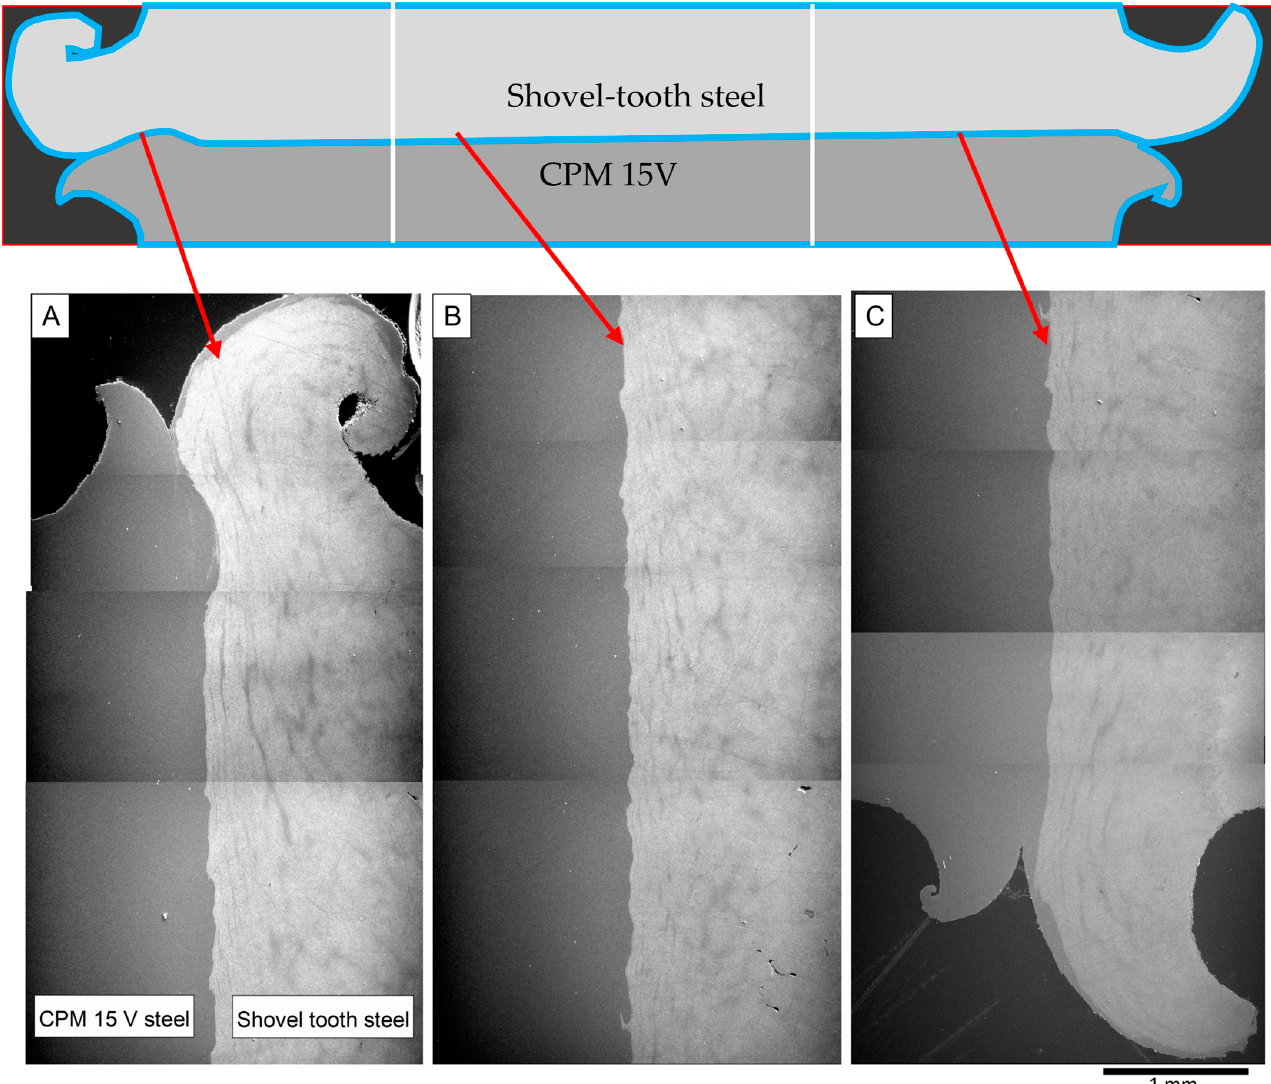
Figure 7. SEM micrographs taken along the entire interface (along Plane A in Figure 2) from ( A ) left, passing through ( B ) the middle, to ( C ) the right of the HF linear friction weld between dissimilar materials CPM 15V tool steel and a shovel-tooth steel .